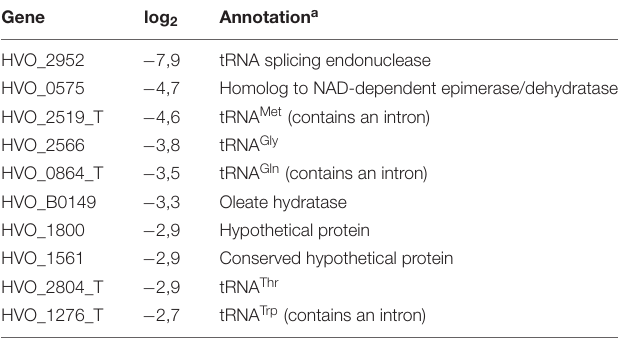
TABLE 1 | Genes down-regulated in the endA CRISPRi strain.